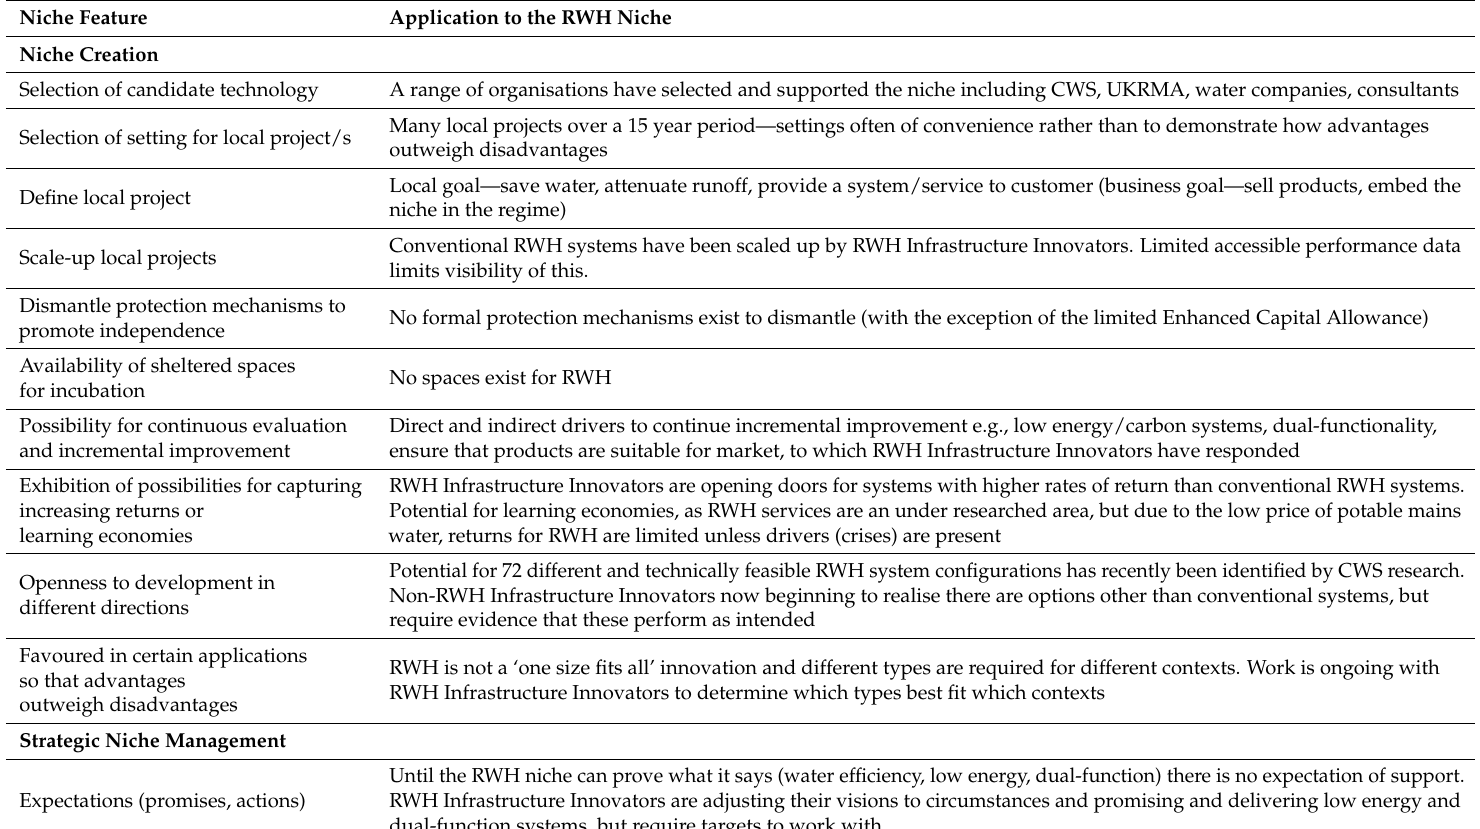
Table 3. Summary of how niche creation and management features are represented in the rainwater harvesting niche in the